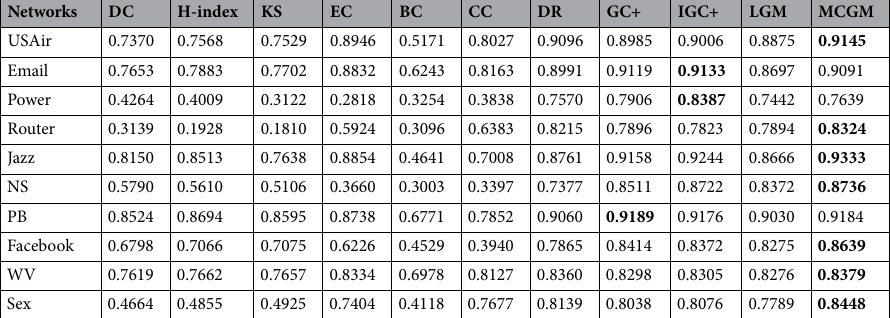
Table 4. The algorithms’ accuracies of MCGM and the benchmark algorithms measured by Kendall’s Tau for β = β c . The parameters in the related algorithms (i.e., LGM and MCGM) are adjusted to their optimal values subject to the largest τ , that is, we need to search the optimal truncation radius which can maximize τ by traversing the truncation radius. Obviously, searching the optimal truncation radius in this way is very time- consuming, fortunately, in subsequent experiments, we find that MCGM still performs very competitively even if the truncation radius is just set to 2. For each network, the best algorithm is emphasized by